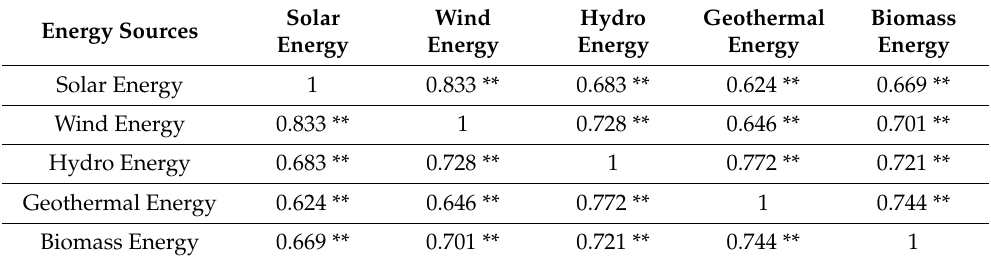
Table 6. Correlation of renewable energy sources. Energy Sources